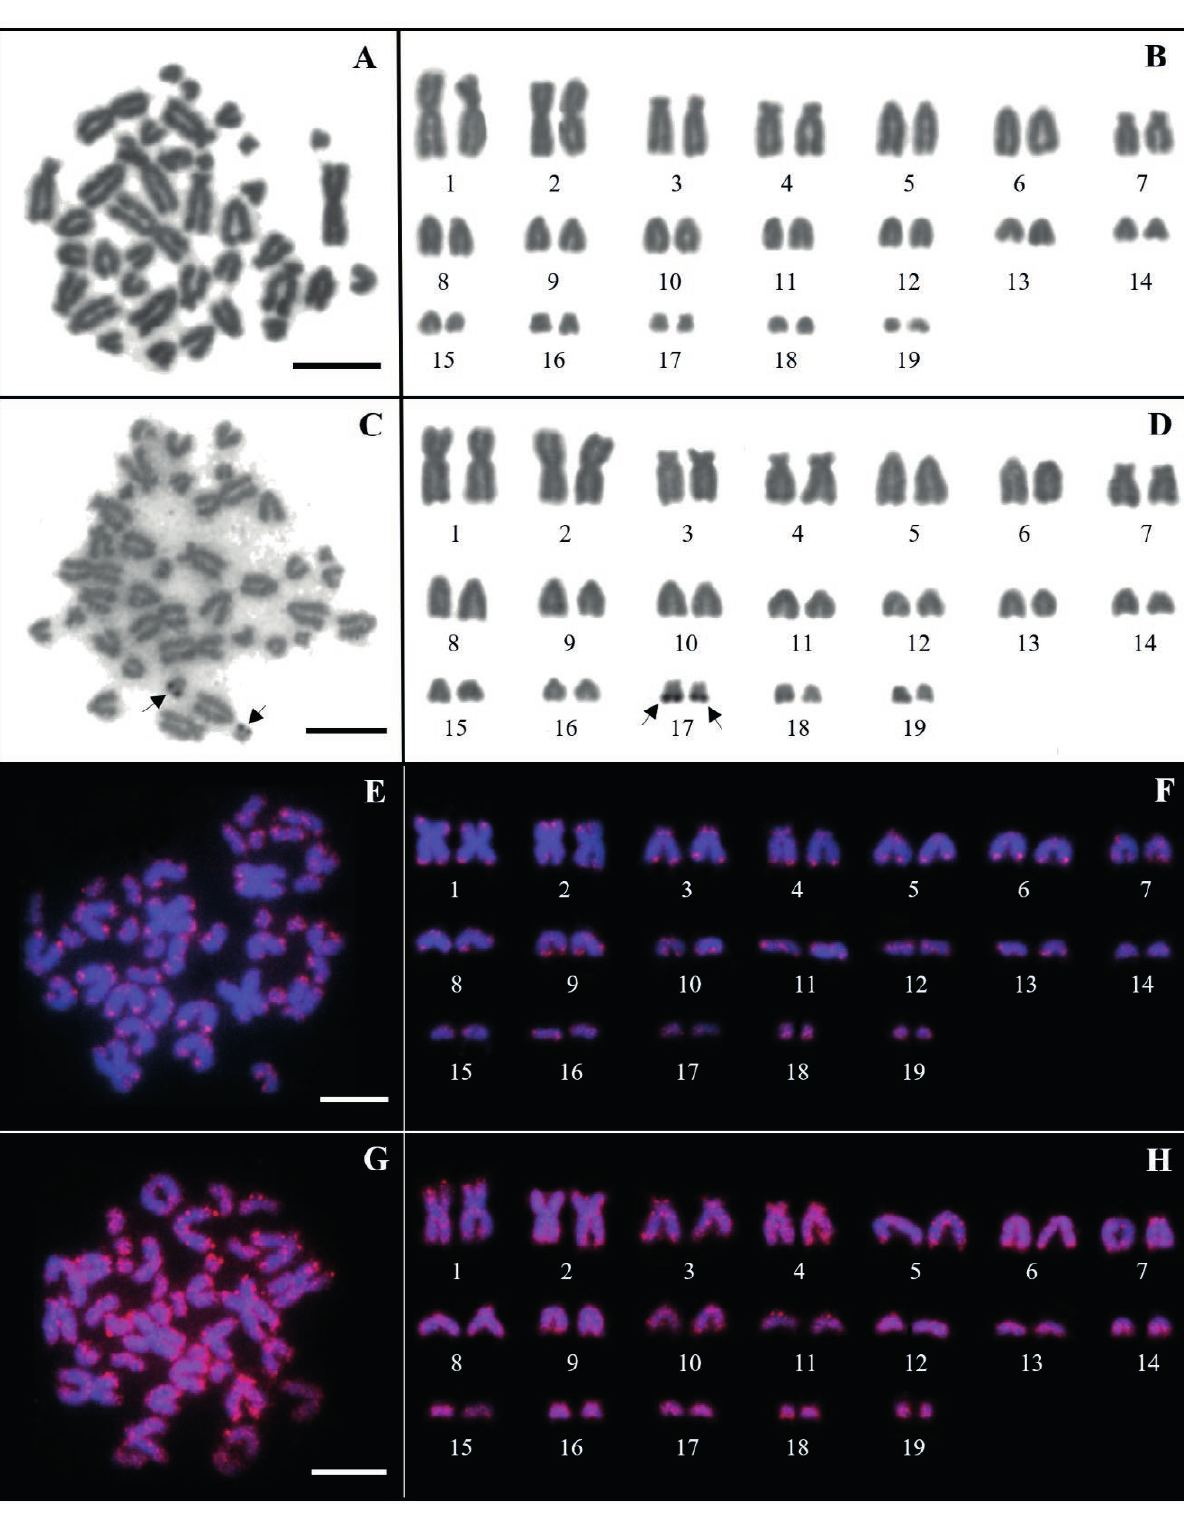
Figure 2. Metaphase chromosome plate and karyotypes of G. petricolus ( A, B ) by conventional technique, ( C, D ) by Ag-NOR banding tech- nique ( A, B ) by FISH technique of microsatellite probe (CA) 15 , ( G, H ) by microsatellite probe (GAA) 10 . Scale Bars = 10